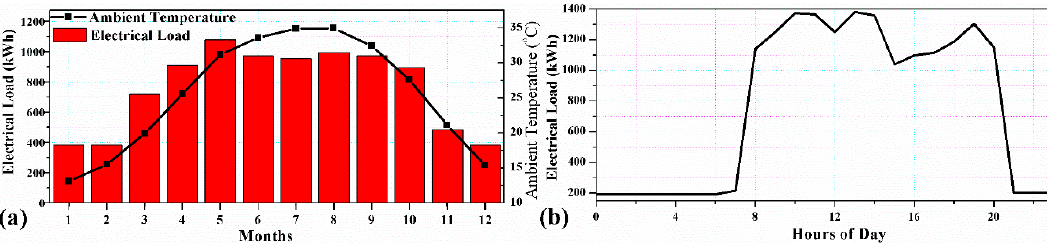
Figure 2. The load curve of College of Engineering in Majmaah ( a ) Monthly average load; ( b ) Daily average load.